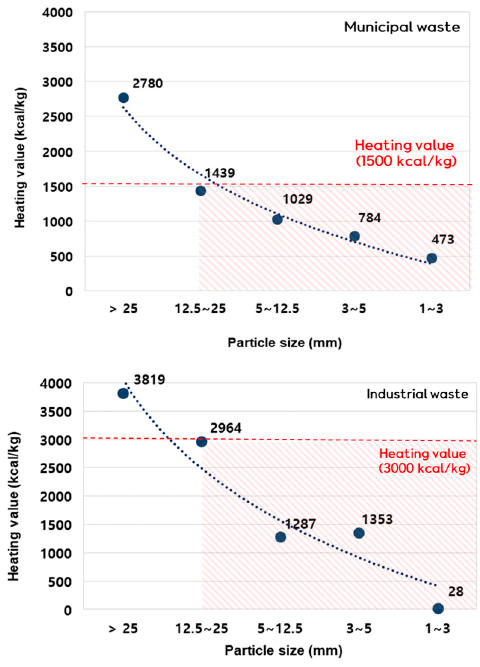
Figure 5. Heating value by particle size of residues.